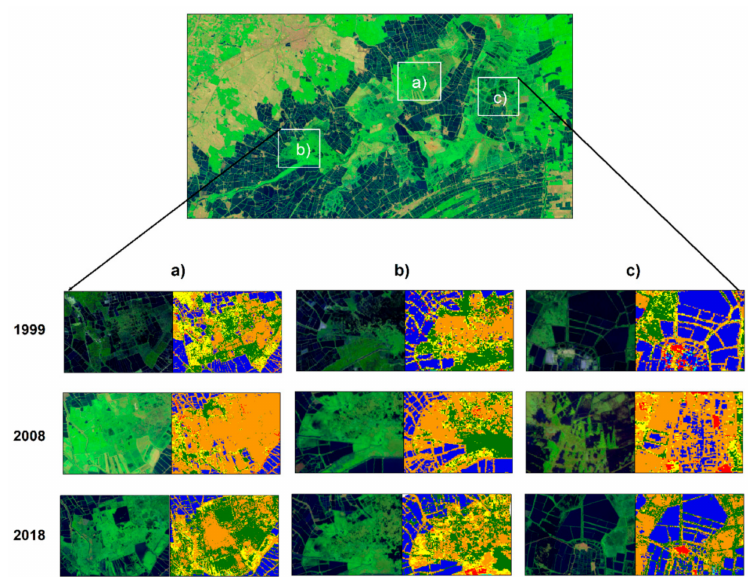
Figure 4. The 30-m Landsat derived land-use classes for the years 1999, 2008, and 2018 for the Kolleru Wildlife